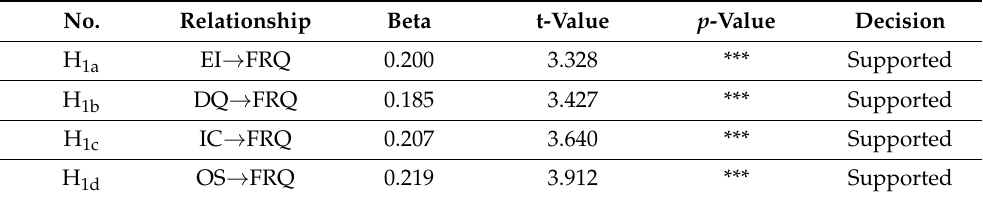
Table 3. Relationship between creative accounting and financial reporting quality.